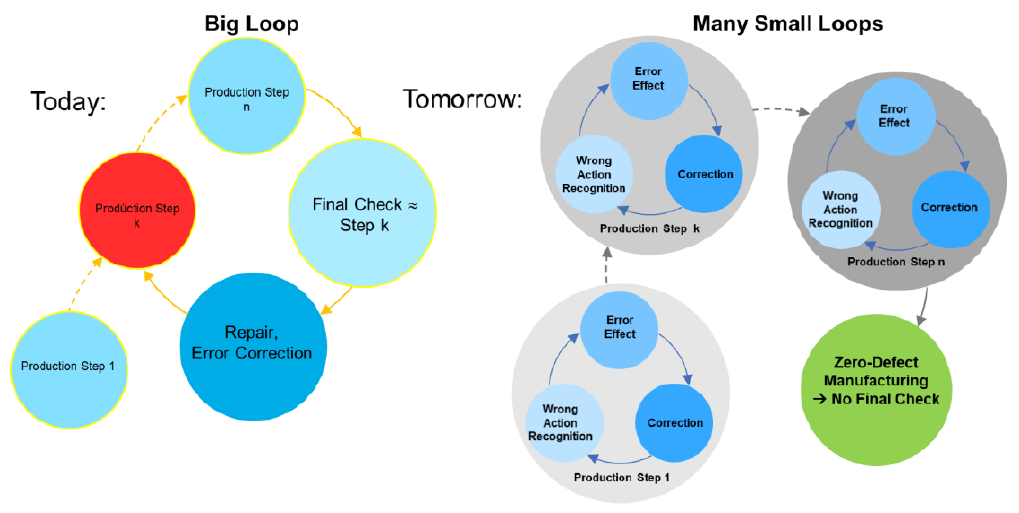
Figure 4. AI-based quality management with incremental error recognition (own illustration).